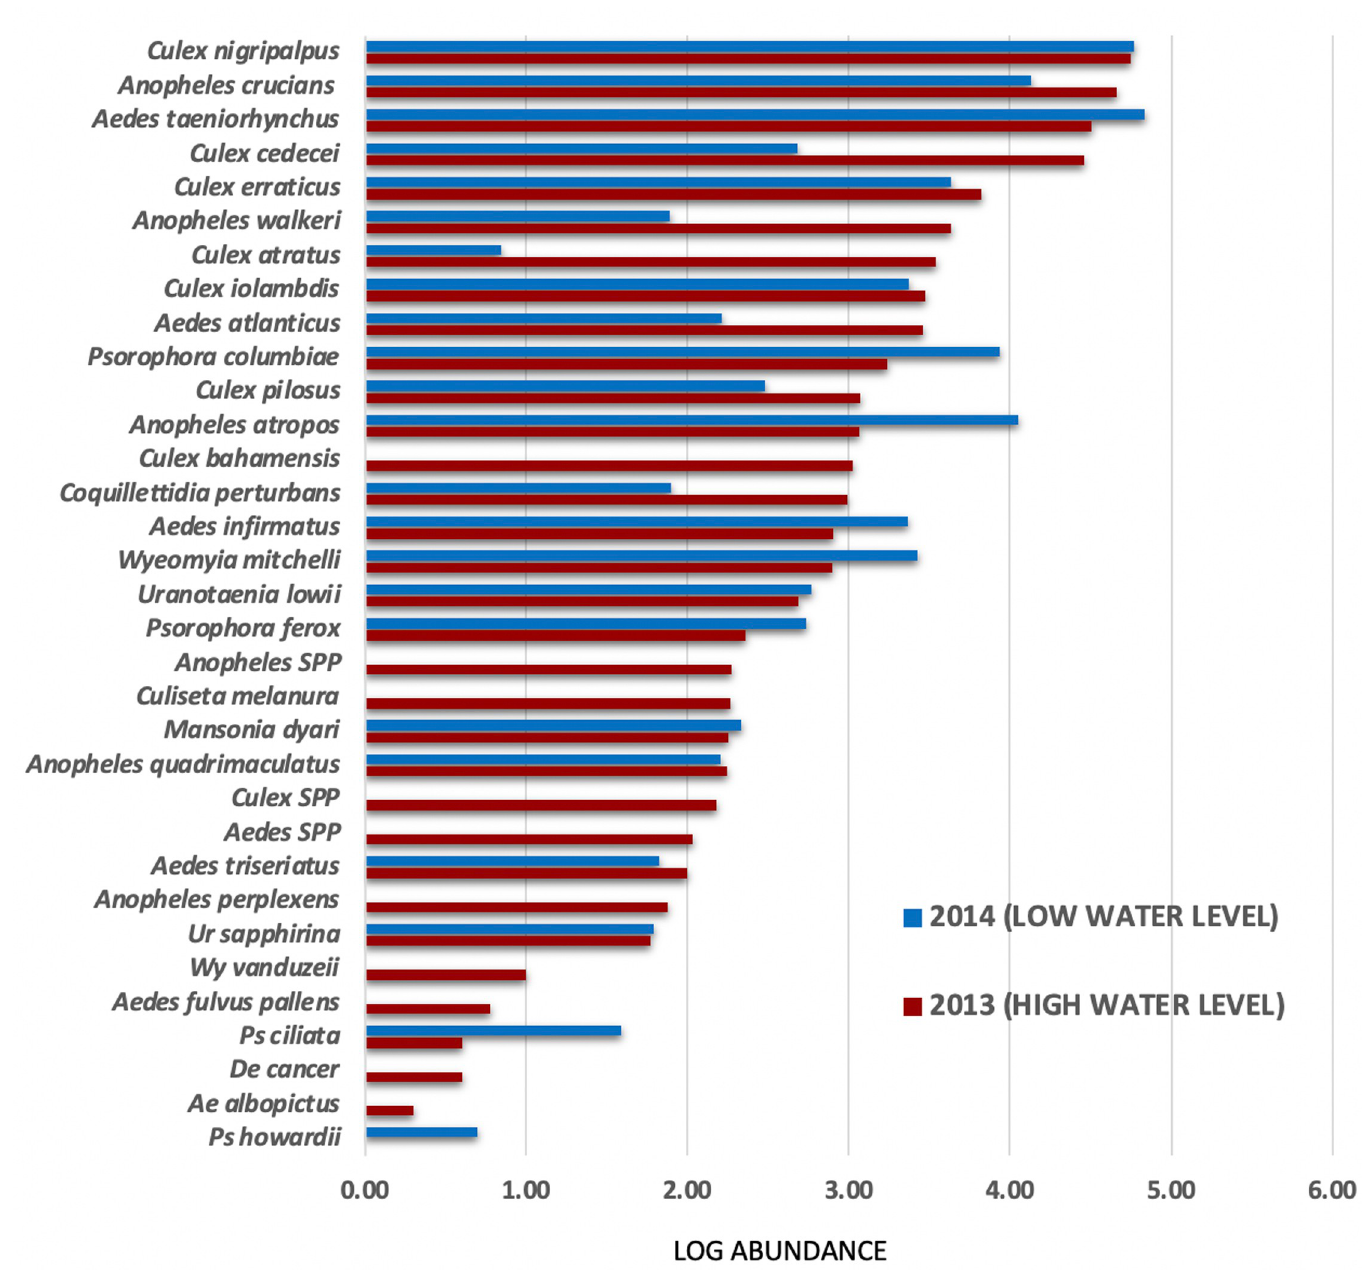
Fig 4. Mosquito abundance. Log abundance of each mosquito species collected in 2013 and